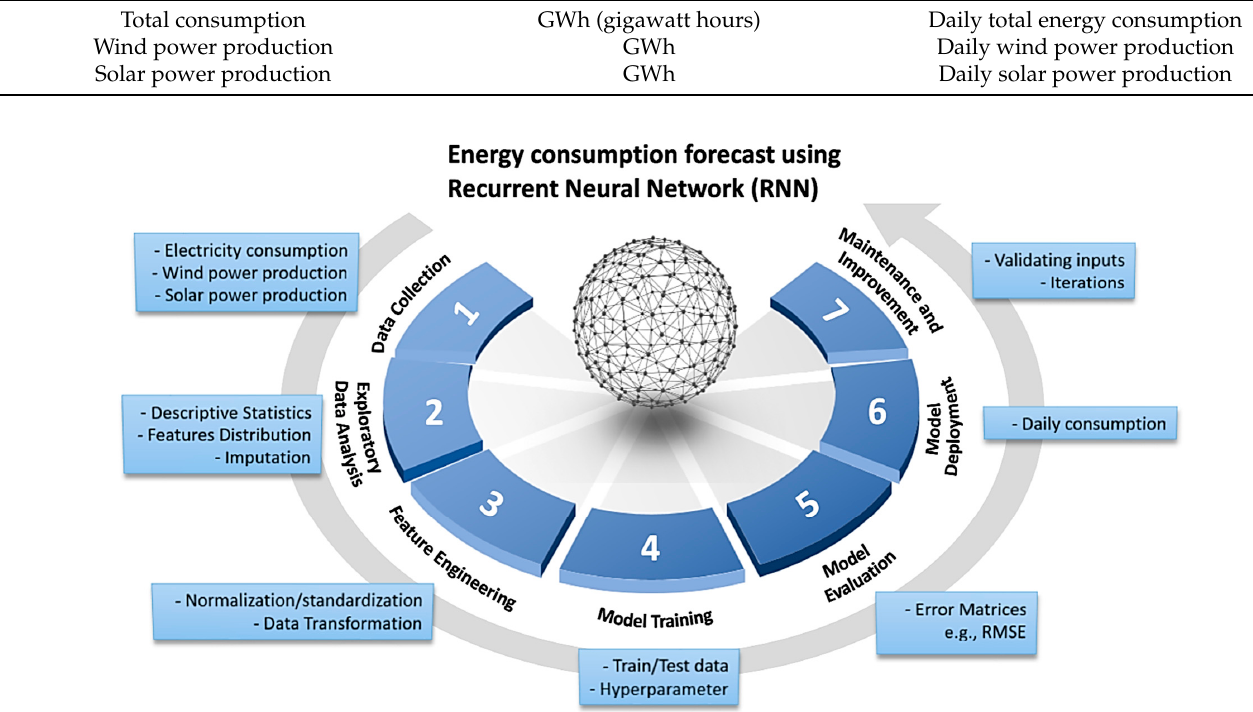
Table 1. Full description of the energy consumption variables used for EDA and predictive analysis with RNN. Unit